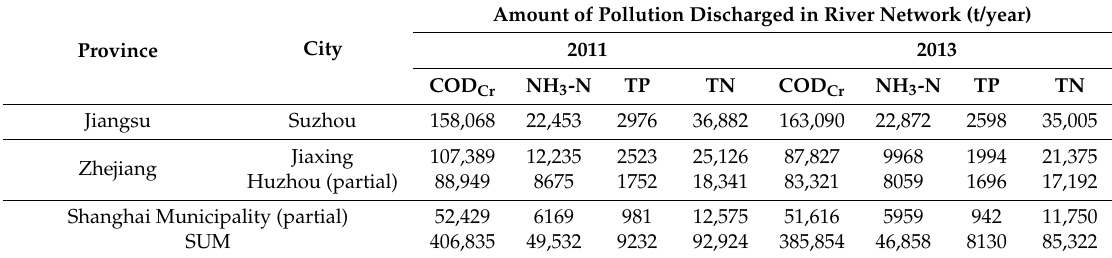
Table 2. Comparison of the amount of pollutants discharged in the study area in 2011 and 2013.